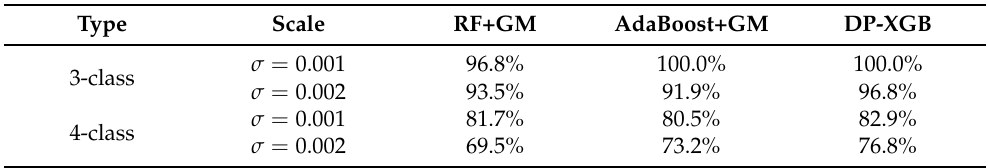
Table 2. Comparative experiment of privacy-preserving algorithms on the task of rice traceability, where GM is the abbreviation of Gaussian